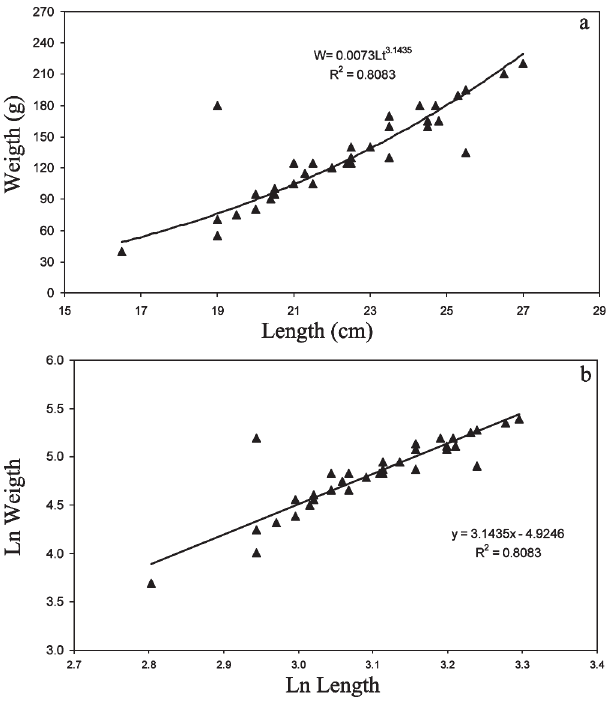
Fig. 1. Weight-length relationship in Cichla temensis (n = 40) farmed in central Amazon. Data values as plotted: a . Values of the determination coefficient/R2; b . Linear